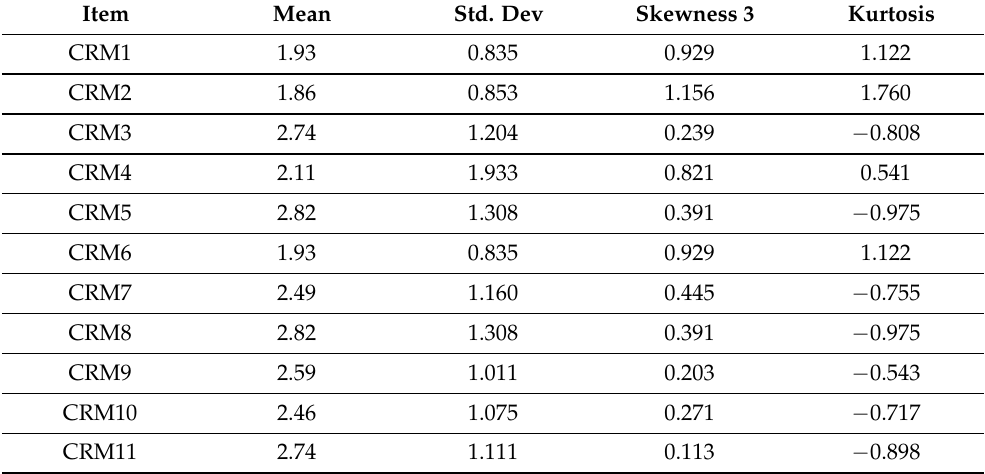
Table 6. Descriptive statistics of CRM